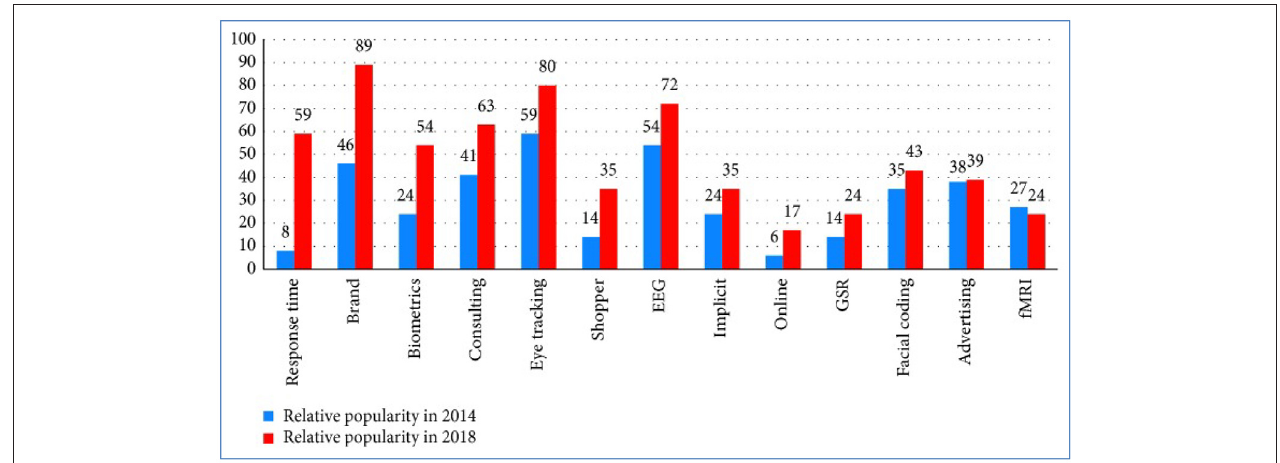
FIGURE 1 | Relative popularity of selected neuromarketing methods, 2014 vs. 2018 (NMSBA, 2018).